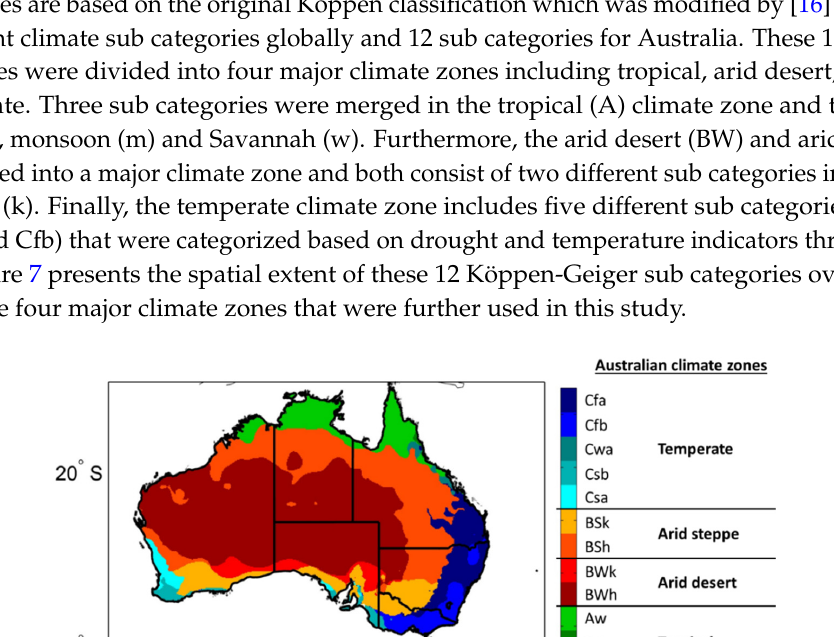
Figure 7. Australia’s major climate zones according to the Köppen-Geiger climate classification.